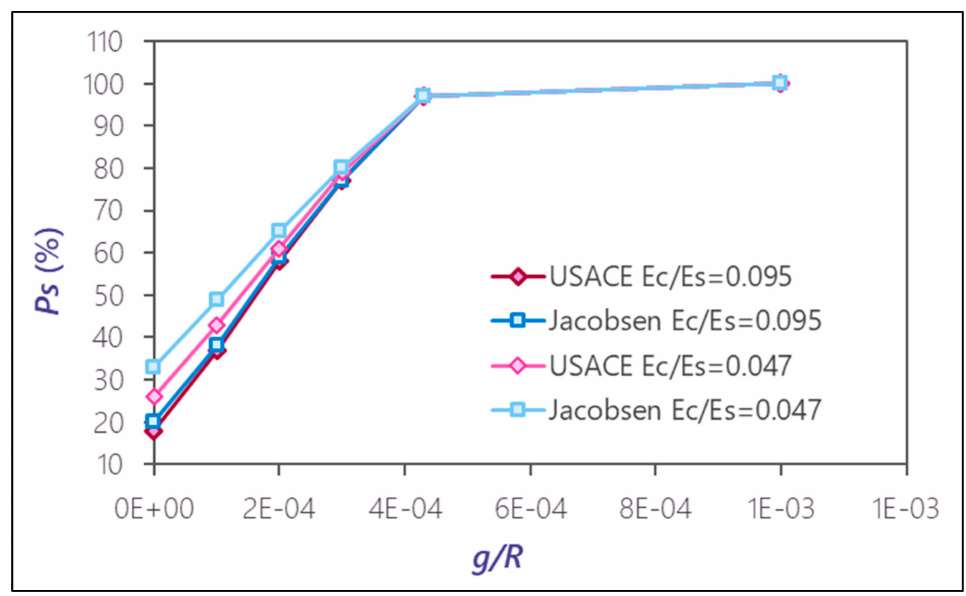
Figure 6. Percentage of internal pressure carried by the steel liner (for D / t = 285.7 and Rfis = 1.5 Rs